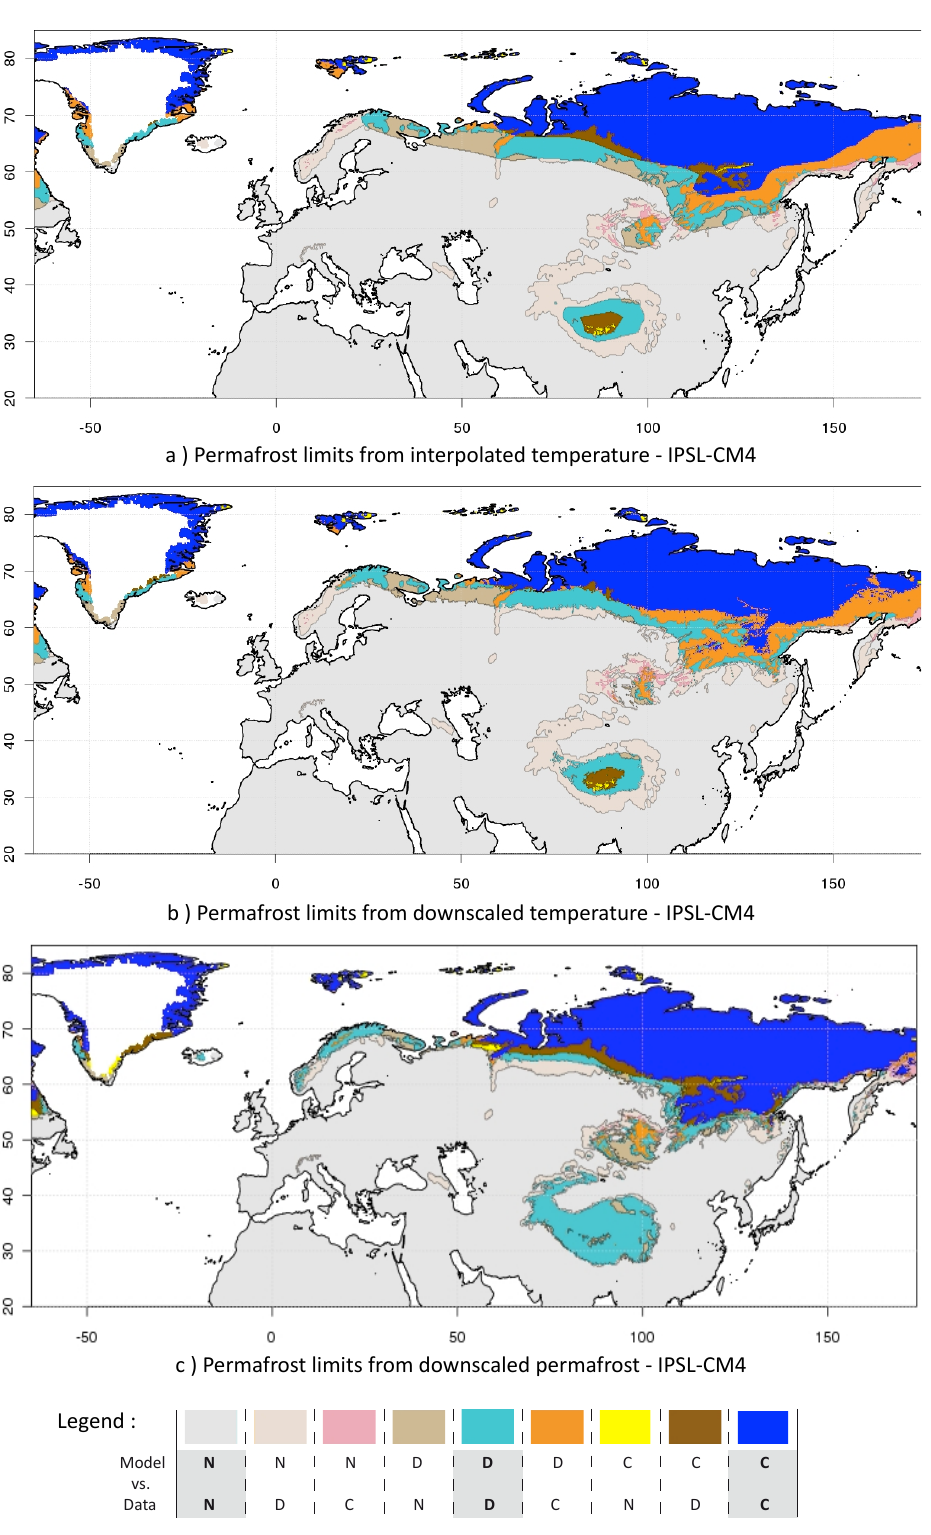
Fig. 4. CTRL permafrost comparison between IPSL-CM4 and the IPA/FGDC permafrost index. (a) Is obtained with a bilinear interpolation of temperatures and the RV conditions to derive permafrost. (b) Is the same from the downscaled temperatures by GAM. (c) Is the downscaled permafrost index by ML-GAM. In the legend panel,“N” corresponds to “No permafrost”, “D” to “Discontinuous permafrost” and “C” to “Continuous permafrost”. The highlighted categories with bold letters show the agreement between model and